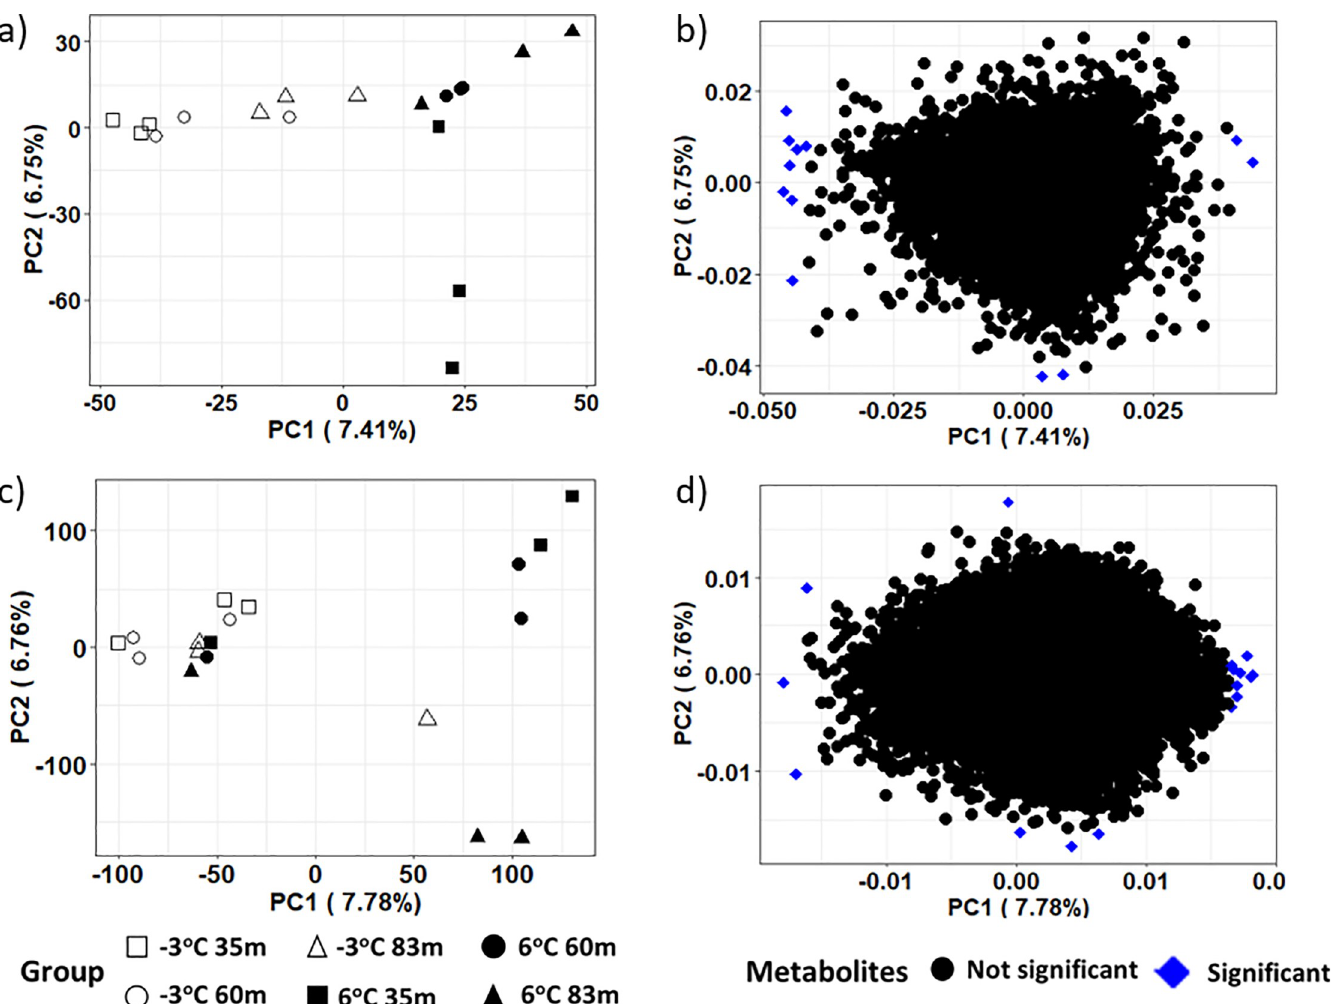
Fig 3. A 2-D plot of the first two principal component (PC) scores and loadings calculated from the unfiltered dataset of the metabolites in permafrost microbial cells at the various locations and thawed from -3˚C to 6˚C. Figures a and b are the PC scores and loading from the ESI+ mode and figures c and d are the PC scores and loadings from the ESI- mode respectively. Variables in the upper or lower 10% of the PCA loadings are the significant metabolites and these significant metabolites are in blue in the loading